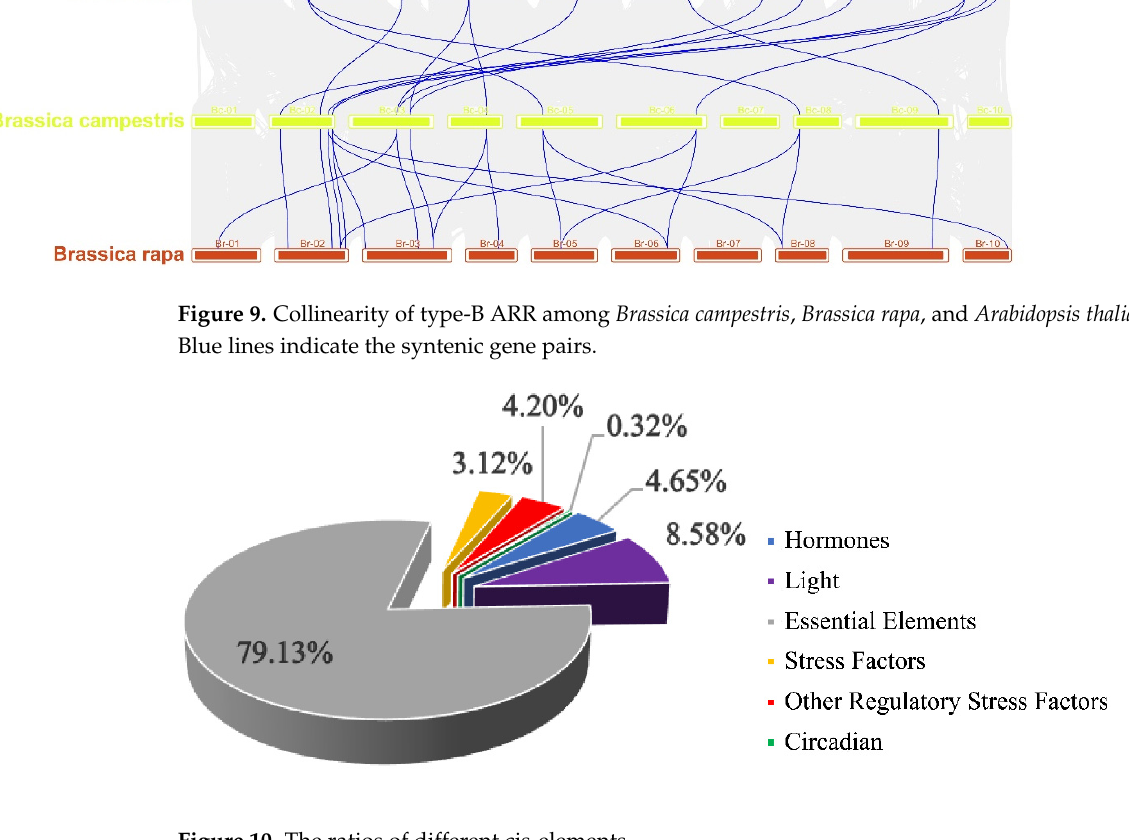
Figure 10. The ratios of different